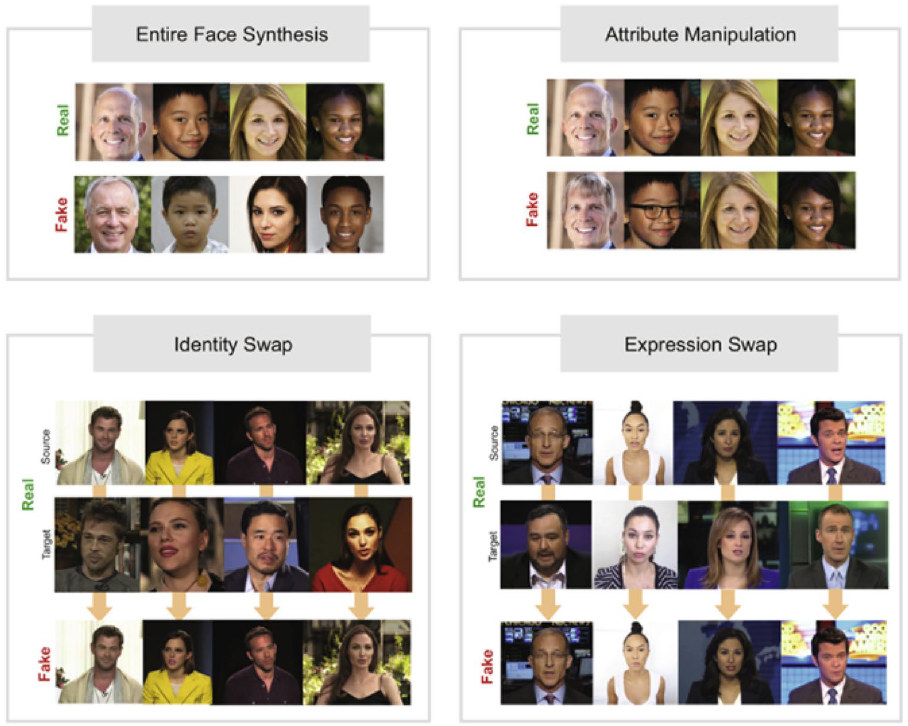
Figure 1. Real and manipulated image examples for each category of facial manipulation techniques 14